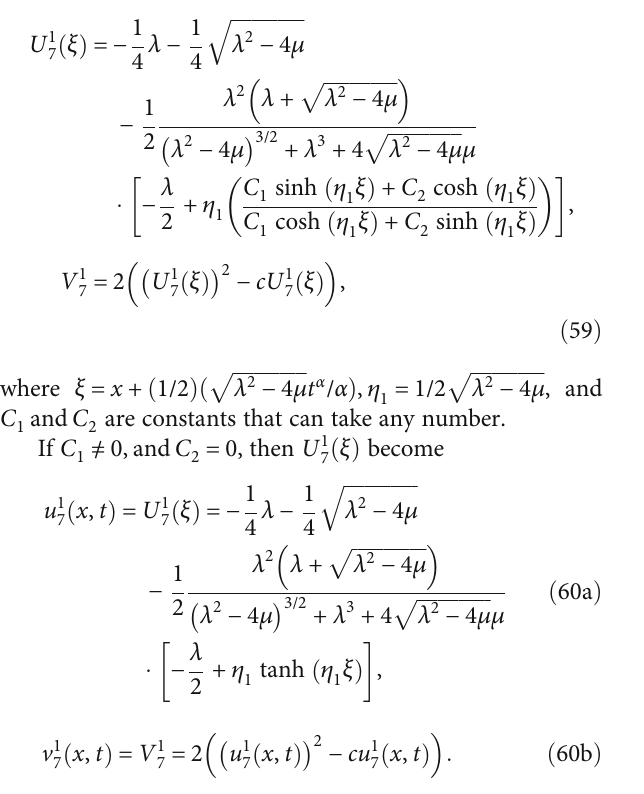
ffiffiffiffiffiffiffiffiffiffiffiffiffiffiffi p λ 2 − 4 μ